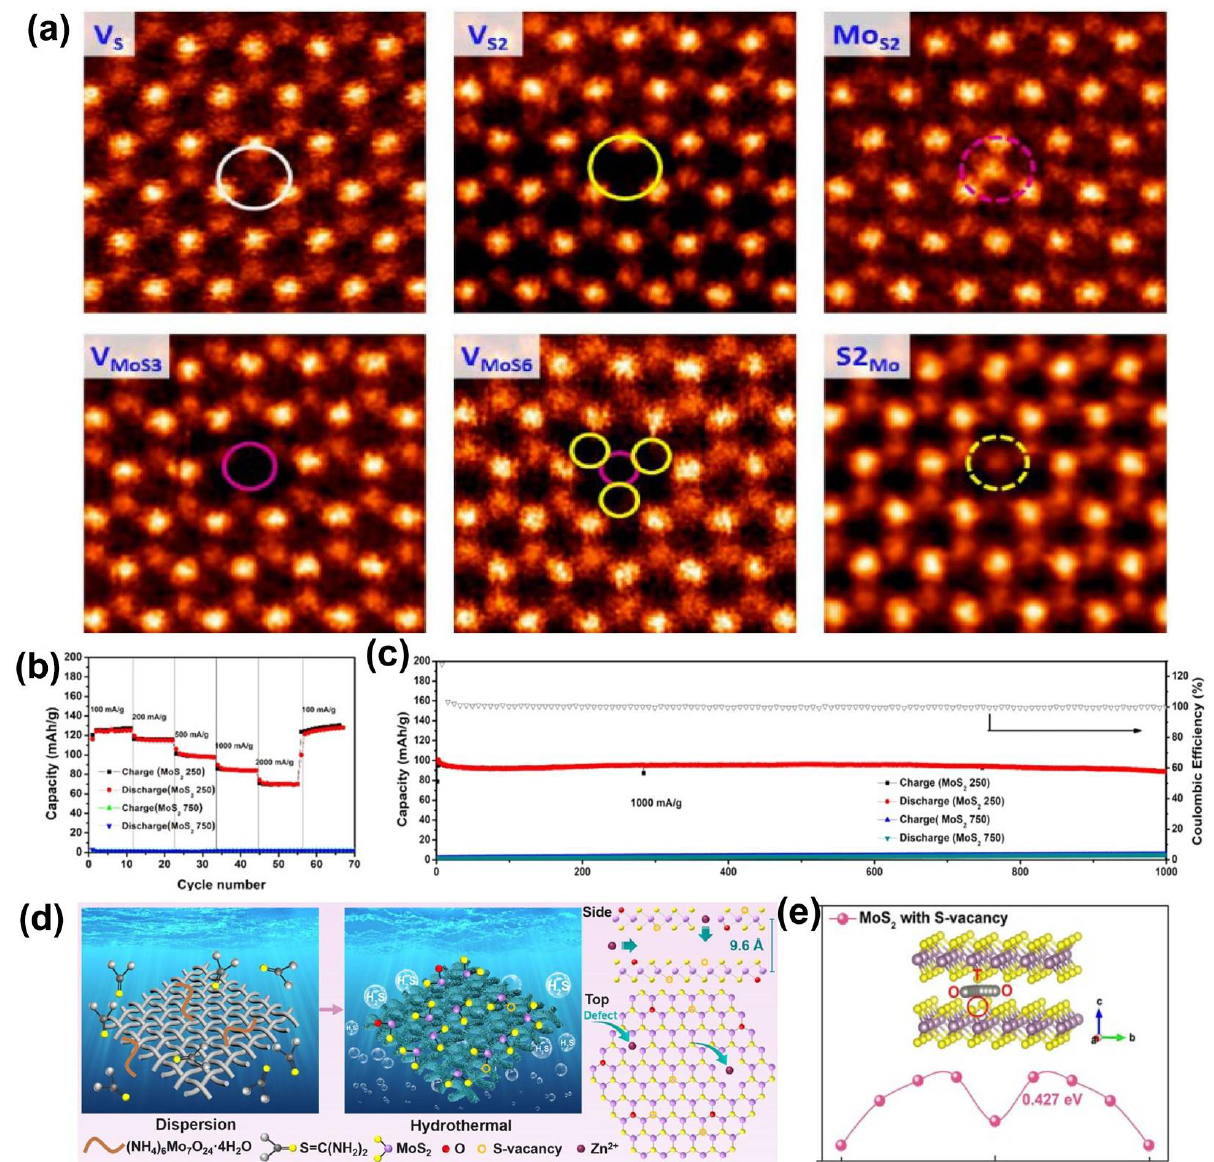
Figure 4. Defect − tailored MoS 2 for ZIB cathode. ( a ) Characterization of various point defects in single − layer MoS 2 , including V S , V S2 , Mo S2 , V MoS3 , V MoS6 , and S2 Mo . Reprinted with permission from Ref. [34]. Copyright 2013, American Chemical Society. ( b ) Rate performance of defect − rich MoS 2 − x at various currents densities. ( c ) Long − term cyclic properties of MoS 2 − x at specific current of 1 A·g − 1 . Reprinted with permission from Ref. [42]. Copyright 2019, Elsevier. ( d ) Illustration of the preparation process and the crystal structure of defect − engineered MoS 2 − O. ( e ) Zn ion migration behaviors along the ab plane in O − doped MoS 2 with S − vacancy. Reprinted with permission from Ref. [15]. Copyright 2021, Wiley-VCH GmbH, Weinheim.